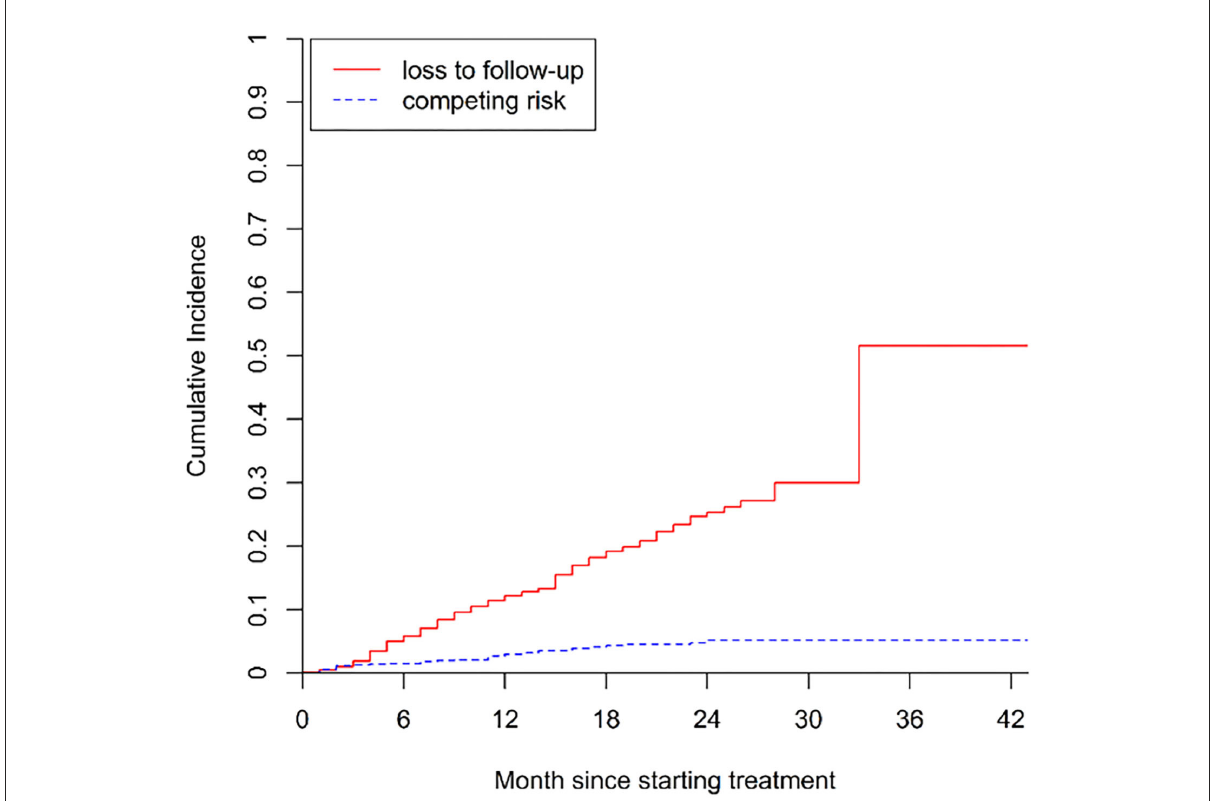
FIGURE3 Cumulative incidence of LTFU (i.e., loss to follow-up) in patients with drug-resistant tuberculosis in Guangzhou, China, from 2016 to